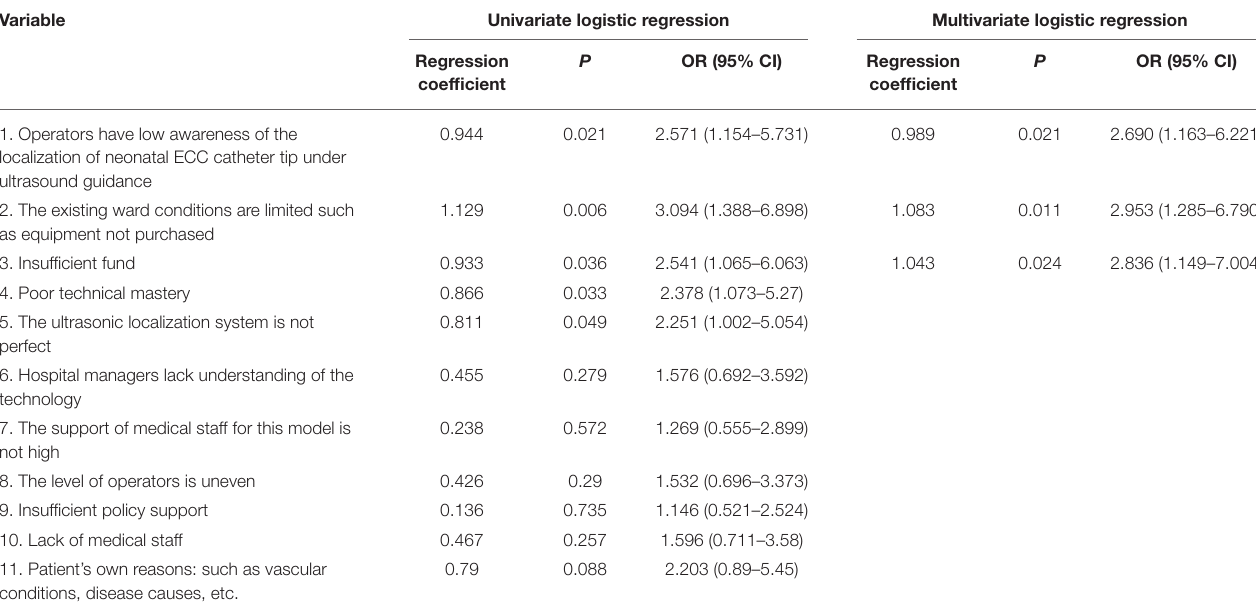
TABLE 7 | Logistic regression analysis of influencing factors of obstruction of neonatal ultrasound localization in hospital ( n = 182).